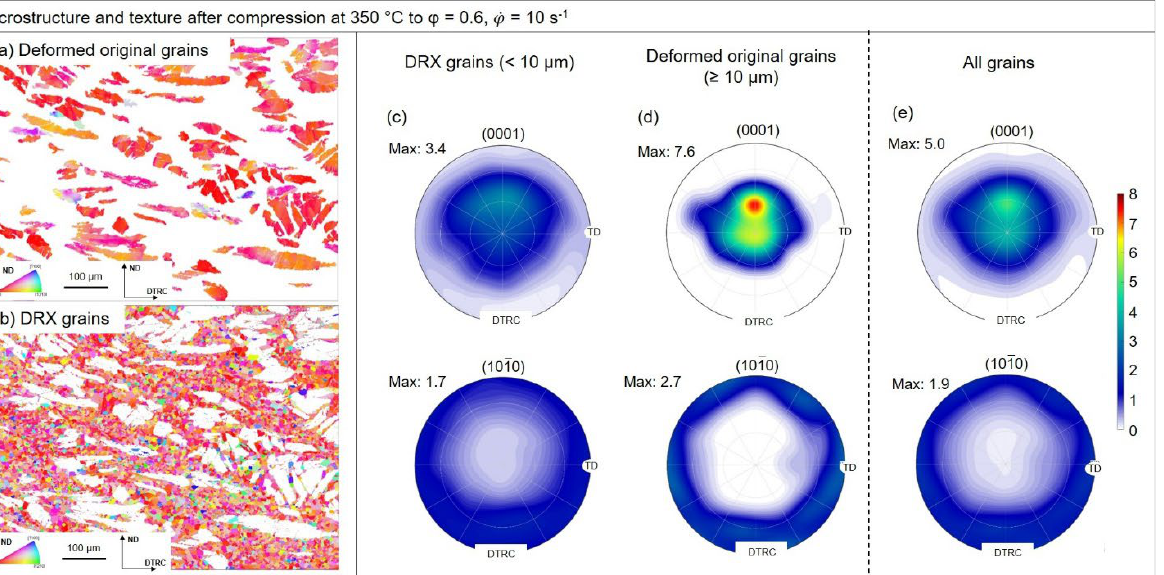
Figure 7. EBSD maps and pole figures of the ZAX210 alloy after hot deformation at 350 °C (equivalent logarithmic strain 0.6, strain rate 10 s − 1 ): ( a ) EBSD map of deformed original grains, ( b ) EBSD map (cid:0) (cid:0) (cid:1) (cid:1) of DRX grains, ( c ) (0001) and 1010 pole figures of DRX grains, ( d ) (0001) and 1010 pole figures of (cid:0) (cid:1) deformed original grains, and ( e ) (0001) and 1010 pole figures of all